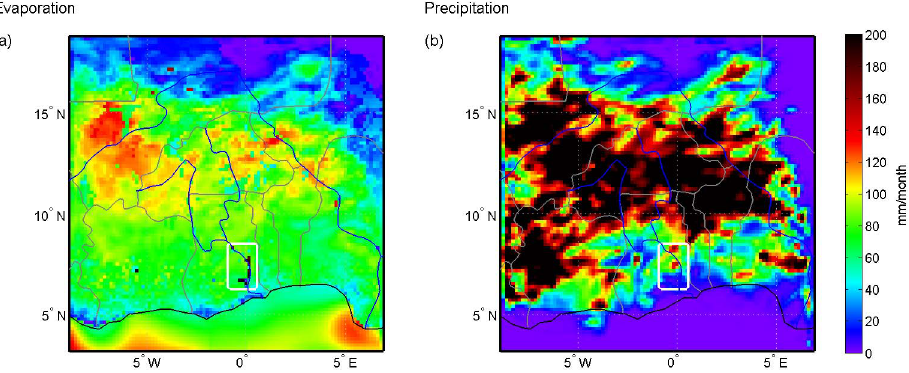
Fig. 2. Vertical fluxes in August 1998 according to the MM5 model run. (a) evaporation, and (b) precipitation. The areal average evaporation of the Lake Volta tagging region is 85mmmonth − 1 compared to 67mmmonth − 1 over the whole domain. The areal average precipitation of the Lake Volta tagging region is 62mmmonth − 1 compared to 87mmmonth − 1 over the whole domain.